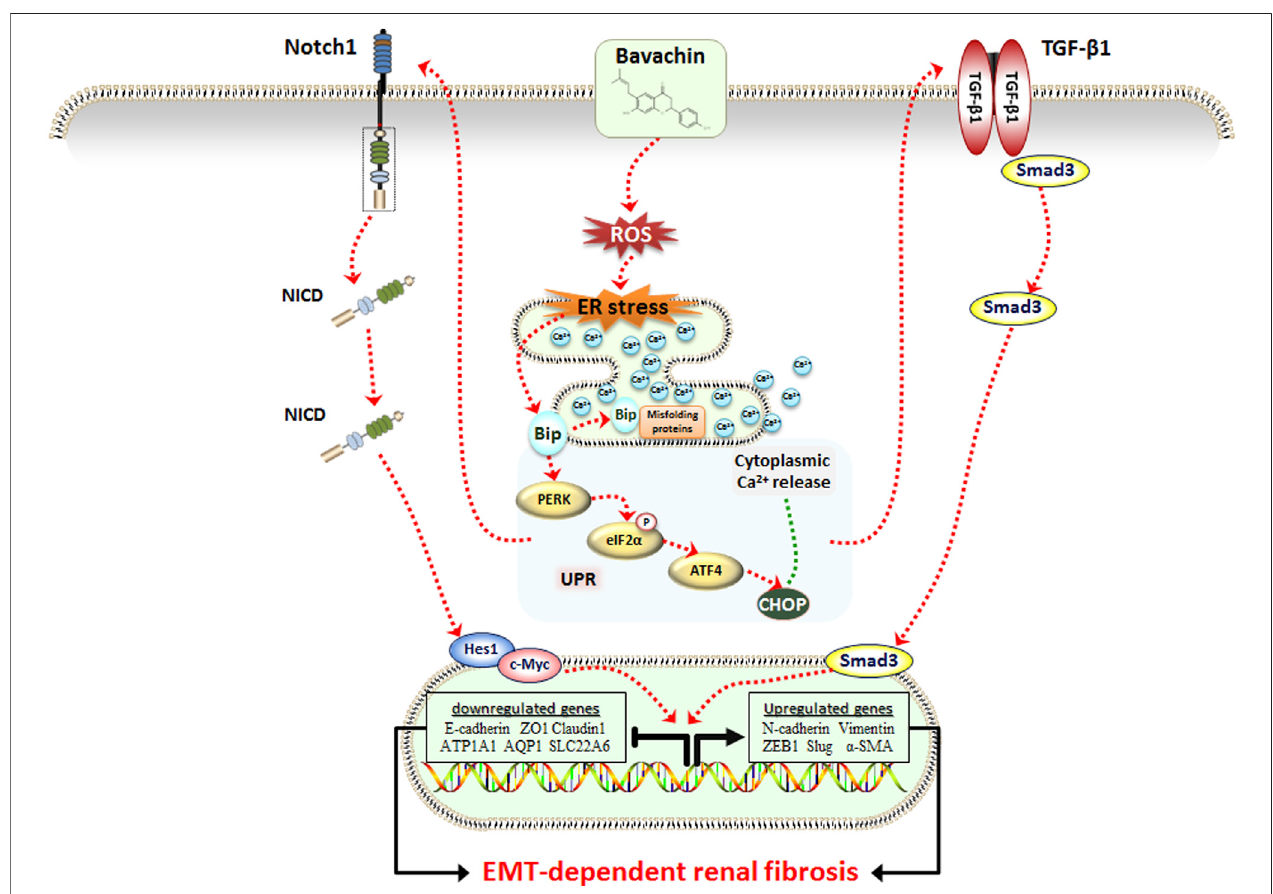
FIGURE 6 | Schematic representation of the potential molecular mechanism underlying BV-induced renal fi brosis.